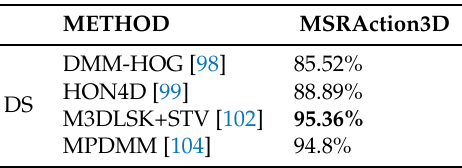
Table 6. Obtained accuracies for the benchmark dataset with depth information based methods.